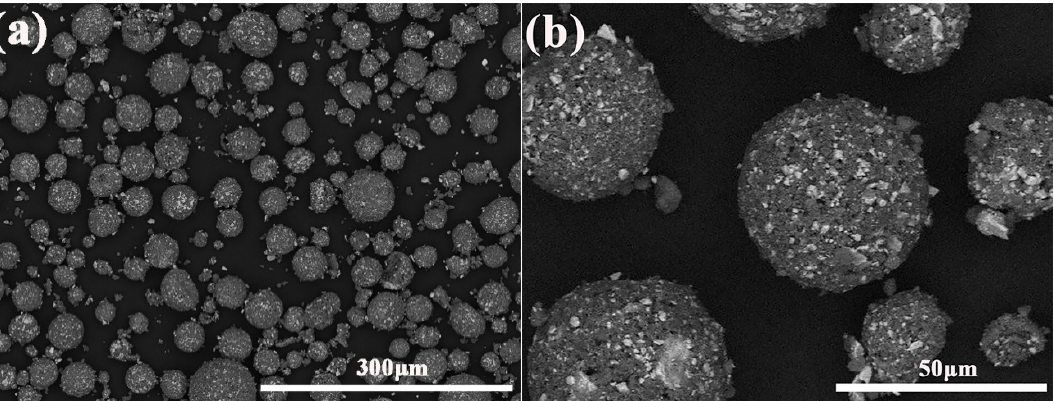
Figure 1. Morphologies of spray granulation powders: ( a ) ×300; ( b ) ×1500.